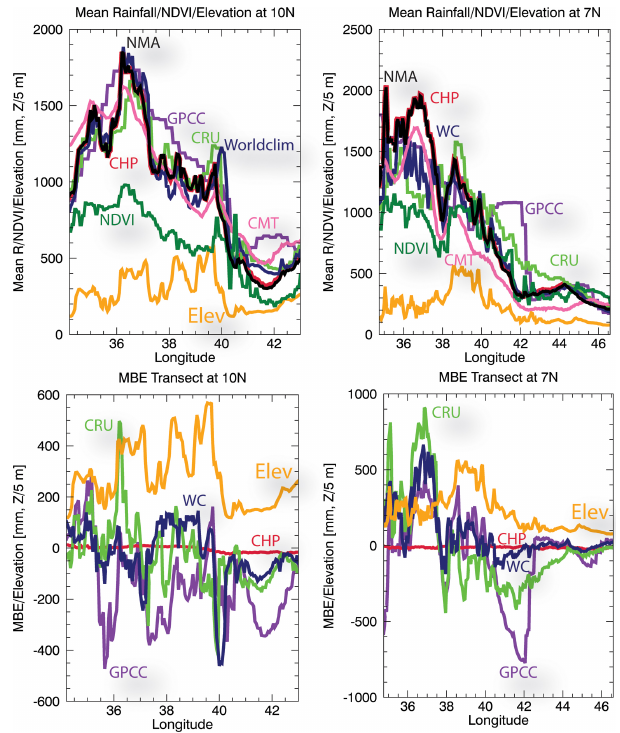
Figure 12. The top panels show transects of total annual rainfall at 7 and 10 ◦ N. Also shown are transects of elevation in meters di- vided by 5 and annual mean NDVI, multiplied by 1500. The bottom panels show MBE transects based on CHPclim, GPCC, CRU and Worldclim minus the NMA data. These bottom panels also show elevation in meters divided by 5.